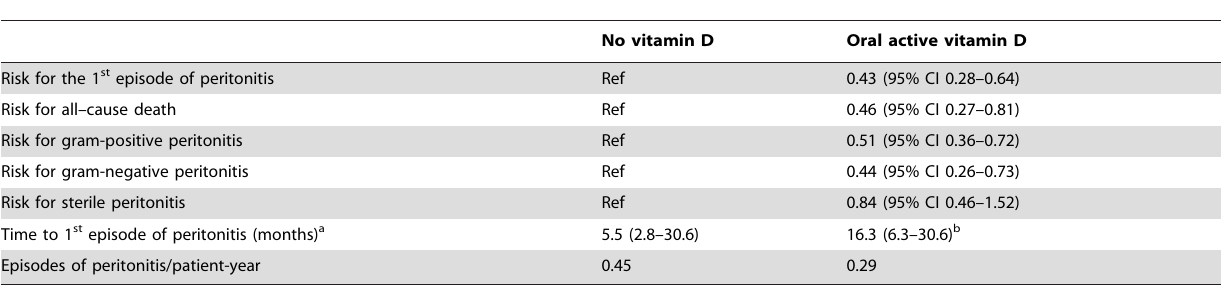
Table 5. Vitamin D and the risk for peritonitis or all-cause death.